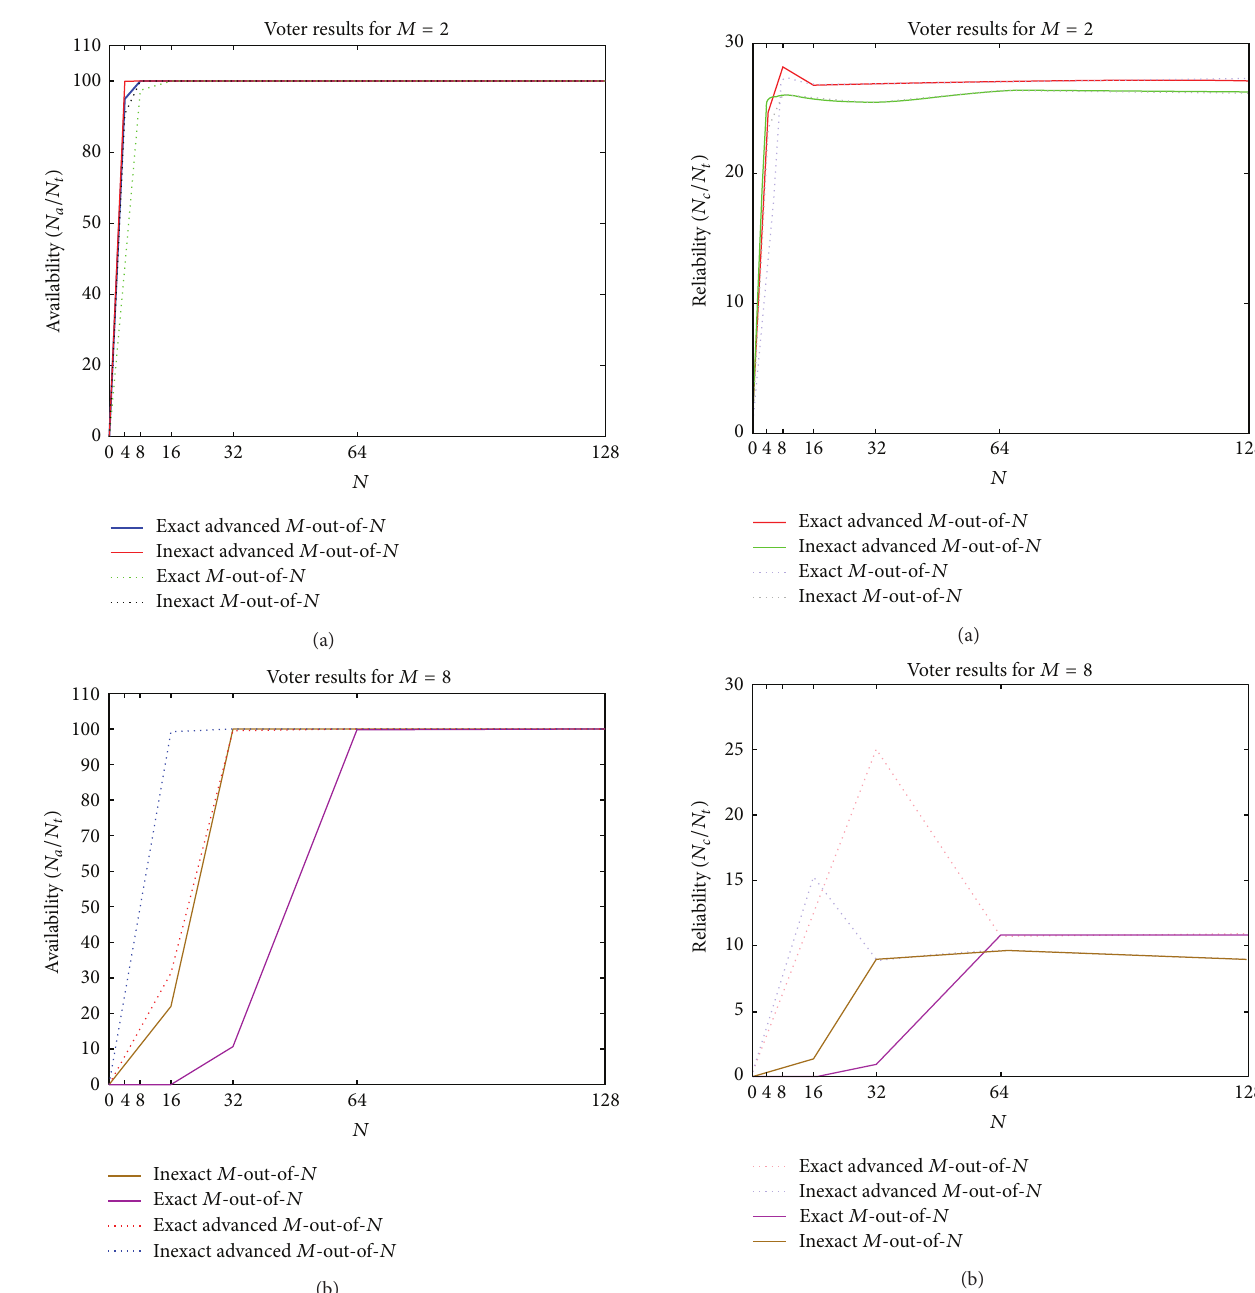
Figure 4: The percentage of agreements (availability) of voting algorithms for (a) 𝑀 = 2 and (b) 𝑀 = 8 .